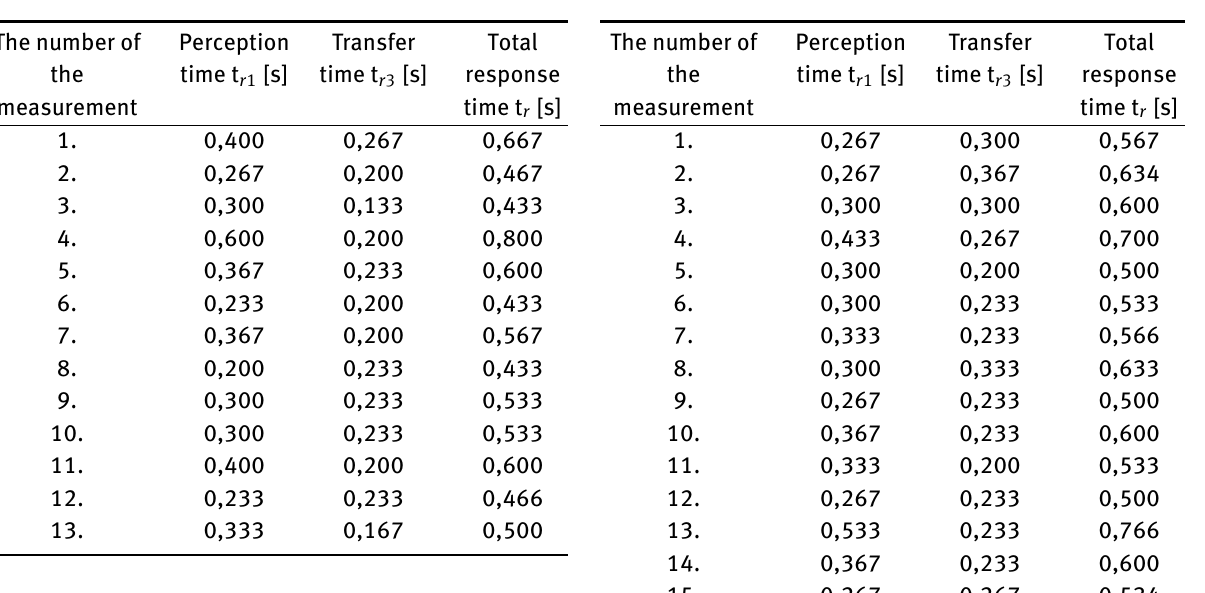
Table 14: Summary of the results of driver I. The number of the measurement